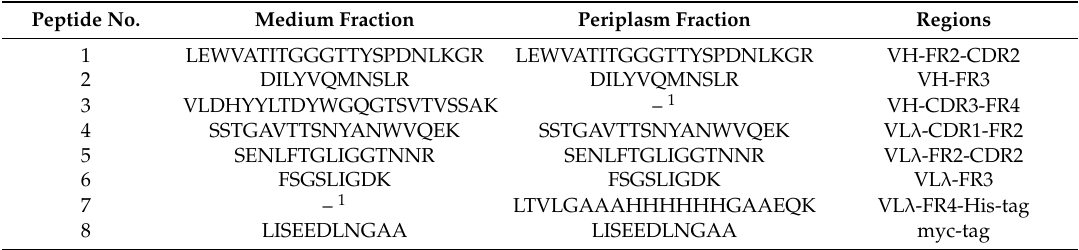
Table 1. Identification of the purified anti-triazophos scFv-8C10 antibody from the medium and periplasm fractions via peptide mass fingerprinting.